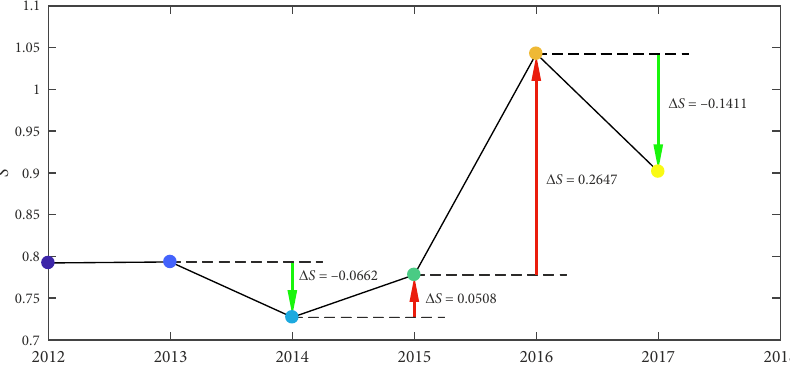
Figure 5. Grey information comentropy evaluation